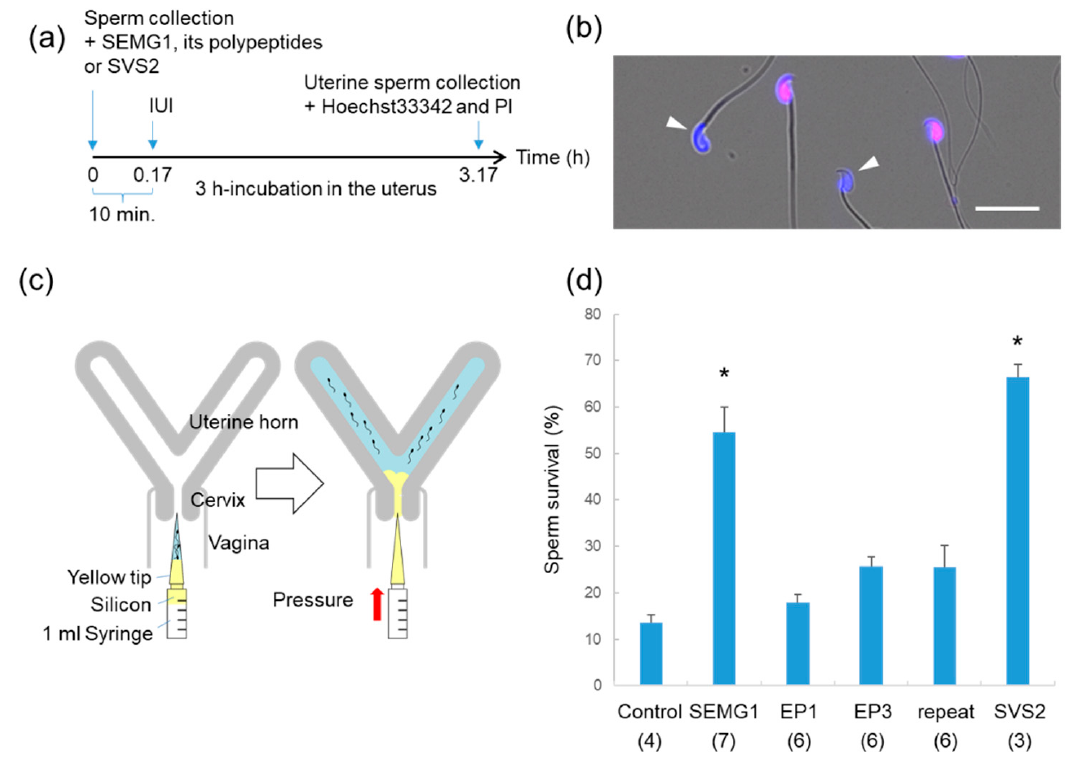
Figure 3. Intrauterine sperm survival after mouse intrauterine insemination (IUI). ( a ) Experimental design for testing intrauterine sperm survival after mouse IUI. ( b ) Image of intrauterine sperm stained